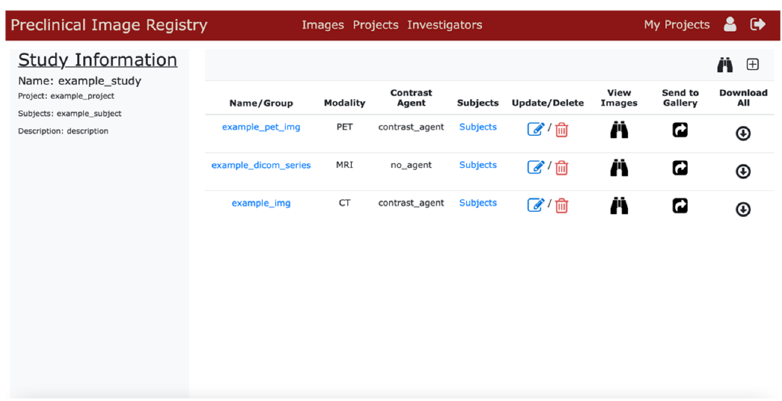
Figure 4. Screenshot of the “Study Manager” view.